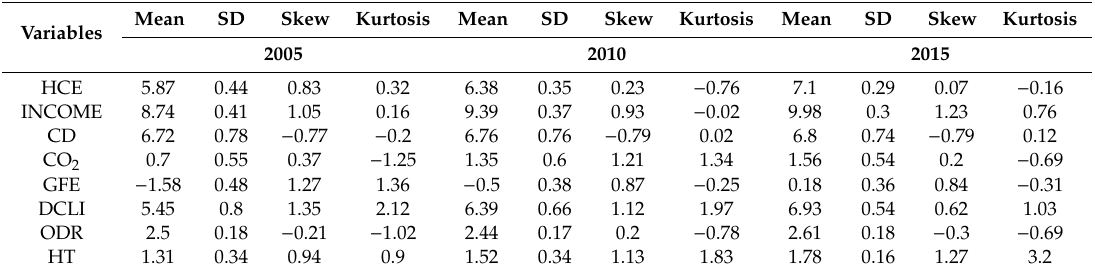
Table 7. Descriptive statistics of all variables (after log